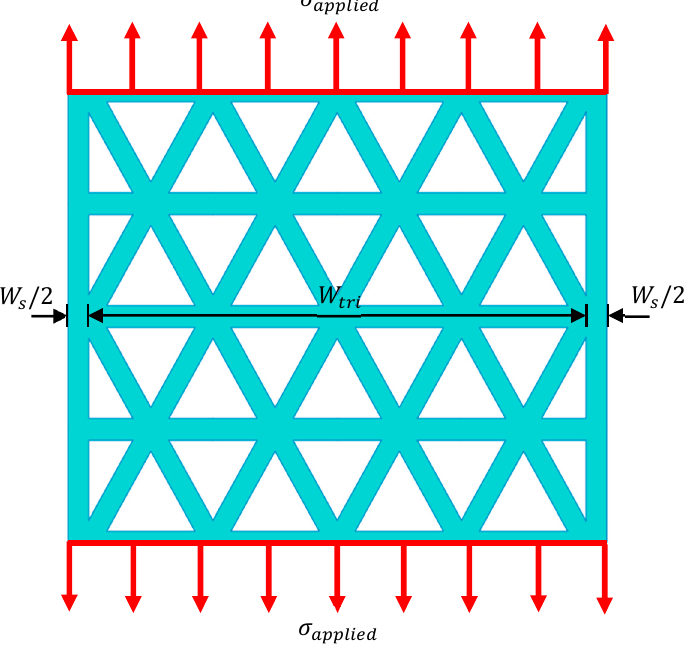
Figure 6. The overall structure of a specimen and its components: solid wall portion (wall side thickness) and triangular lattice portion (interior).